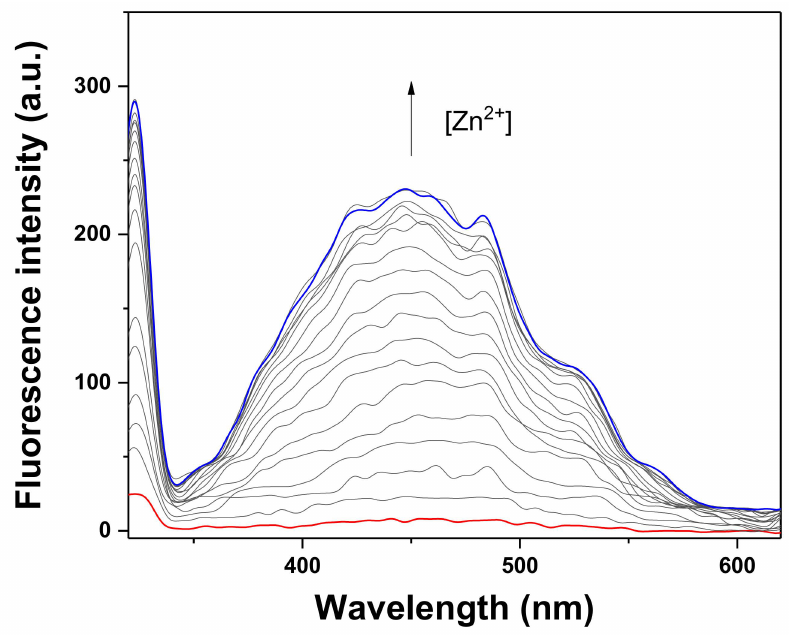
Figure 2. Fluorescence spectral response of TCC (4.0 × 10 − 5 M) with varied concentrations of Zn 2+ ( λ ex = 320 nm). The arrow from bottom to top represents that fluorescence emission increased with the increasing Zn 2+ (0, 4, 8, 12,16, 20, 24, 28, 32, 36, 40, 44, 48, 52, 56, 60, 64 and 68 µ M).